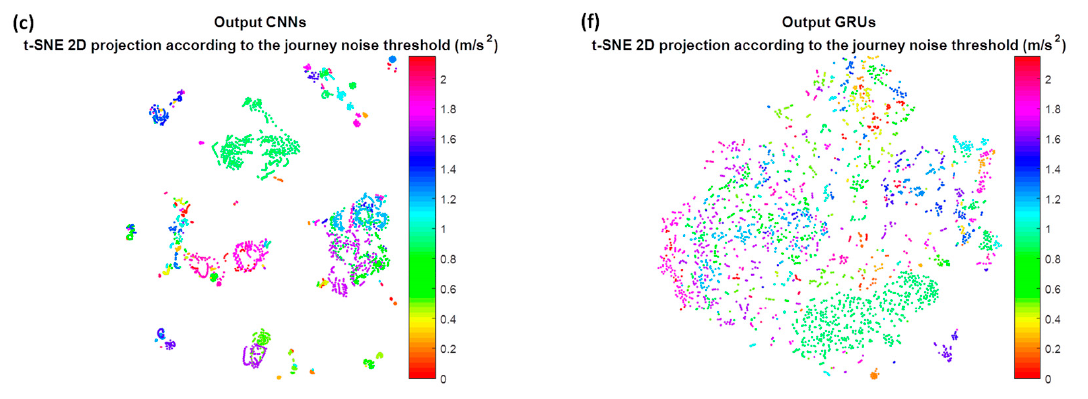
Figure 12. Two-dimensional t-distributed stochastic neighbor embedding (t-SNE 2D) projections of feature vectors for raw accelerometers input signals to the output of the convolutional network (CNN) (left representations) and gated recurrent unit (GRU) network (right representations). ( a , d ) Projection depends on type of acceleration force. ( b , e ) According to gravity distribution. ( c , f ) According to noise threshold of the journey (m/s 2 ).